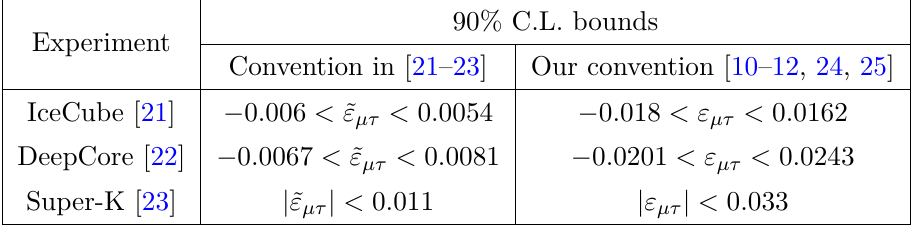
√ = 2 G ˜ ε , while we use the NSI F N d µτ 3 N in Earth, the bounds d ≈ e , using ε = 3 ˜ ε , as shown in the µτ µτ µτ